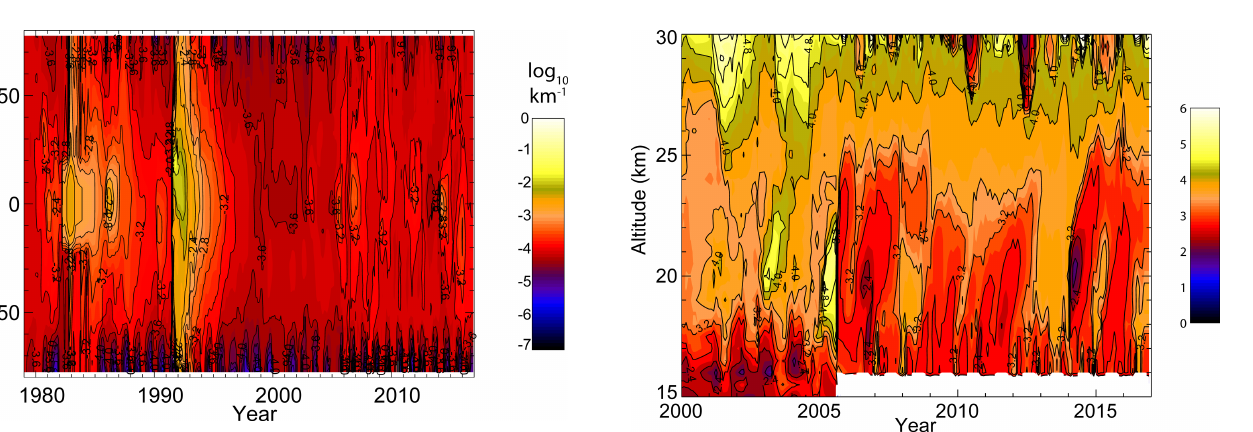
Figure 15. Ratio of GloSSAC 525 to 1020nm extinction coefficient at 2.5 ◦ N for 2000 to 2016. The switch from primarily SAGE II to OSIRIS occurs in mid-2005 with CALIPSO also contributing, beginning in